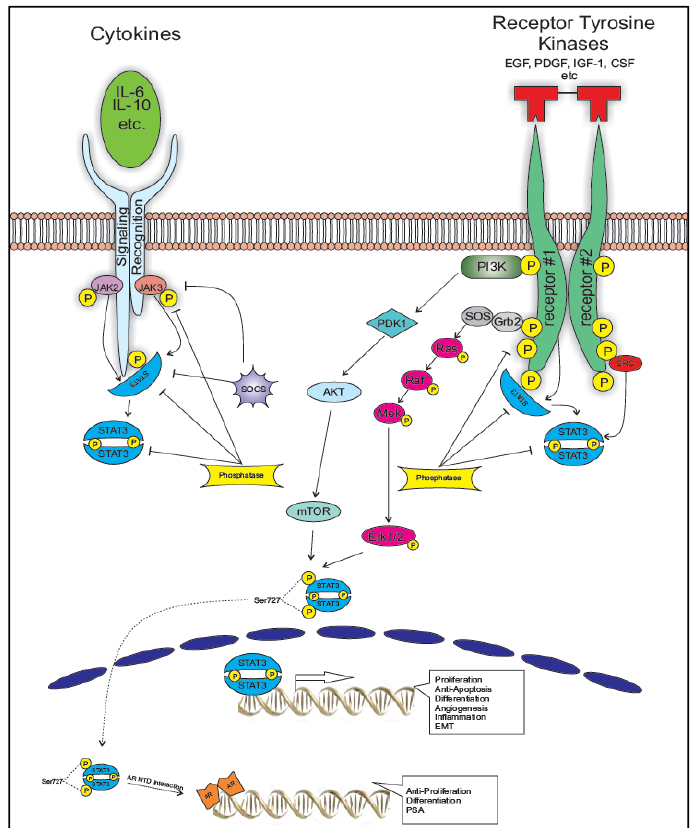
Figure 1. STAT3 integrates different signaling pathways involved in prostate cancer progression to metastatic disease. Binding of ligands to Cytokine Receptors and or Receptor Tyrosine Kinases recruits non-receptor Tyrosine kinases (JAK family and Src family) through their SH2 domains to the receptors. The same SH2 interaction also recruits STAT3 to the receptors and STAT3 gets phosphorylated on Tyrosine 705 by the non-receptor kinases leading to its dimerization, nuclear translocation and binding to DNA of target genes involved proliferation (CyclinD1, cMyc, Mcl1), Angiogenesis (Hif1 α and VEGF), EMT (Twist, MMP2, 9, 7). In addition to this, the activity of mTOR and MAPK pathways phosphorylates STAT3 at Serine 727 which directly interacts with the NTD of the Androgen Receptor promoting its differentiation activity without increasing cell